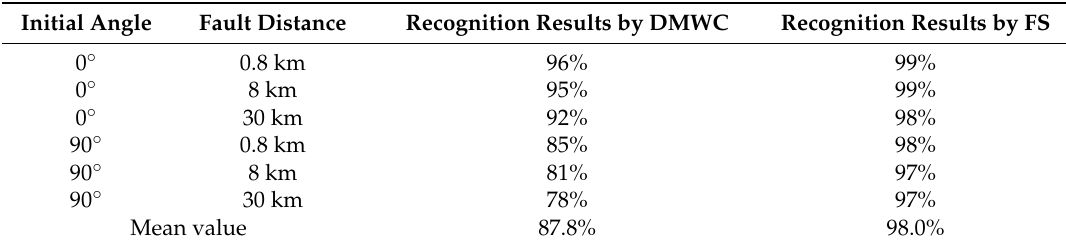
Table 8. Comparison of DMWC and FS with different fault